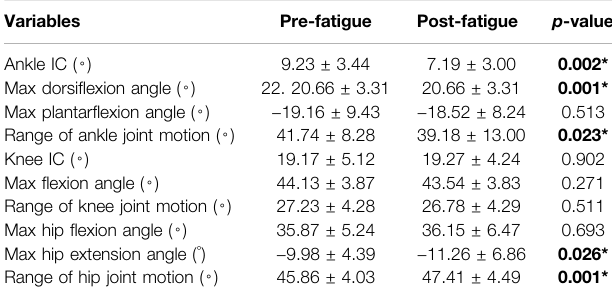
TABLE 3 | Lower extremity joint kinematics pre-fatigue running and post- prolonged fatigue running (x ± SD). Variables